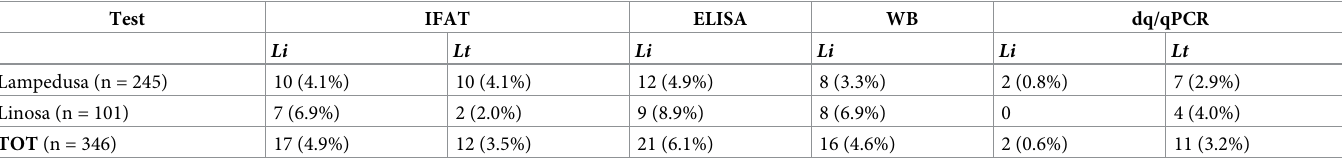
Table 1. Number and prevalence of humans exposed to or infected by L . infantum ( Li ) and L . tarentolae ( Lt ) based on the serological and molecular diagnostic tests and geographical origin.